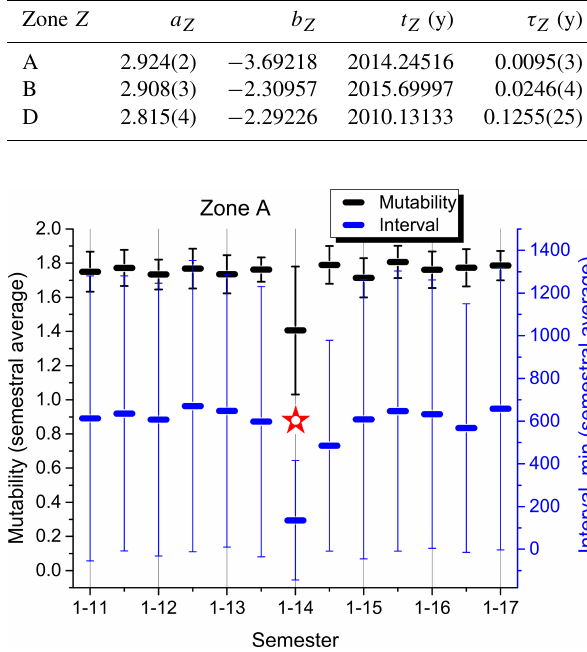
Figure 9. Semestral average of mutability values (upper symbols; black) and intervals in minutes between consecutive seisms (lower symbols; blue) for zone A (Iquique). Odd semesters are labeled on the abscissa axis (1–13; first semester of 2013), while even semesters are only marked. A star identifies a semester with an earthquake with a magnitude over 8.0.